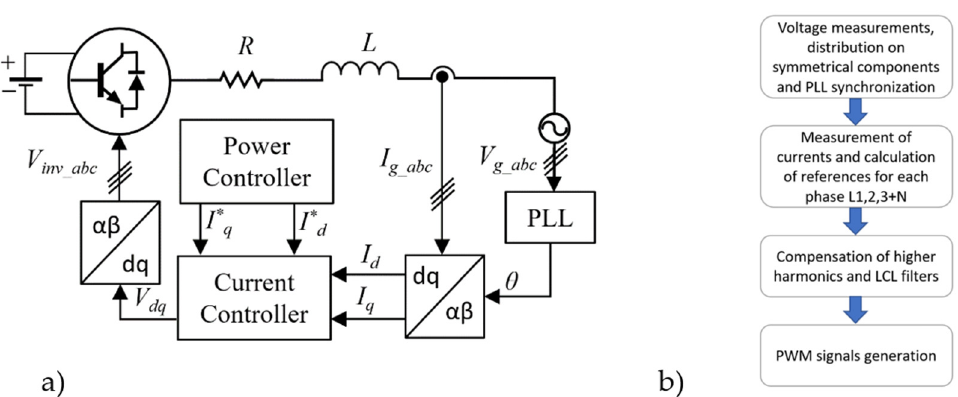
Figure 3. ( a ) Typical control structure of a converter integrated with renewable energy sources. ( b ) The flowchart of the multi-resonant algorithm. I * q, I * d —Reference current value in dq frame; Id, Iq —feedback currents after Park transform; V dq —voltage signals in dq frame; I g_abc , V g_abc —Three phase instantaneous currents and voltages. V inv_abc —three phase reference signals for PWM module.